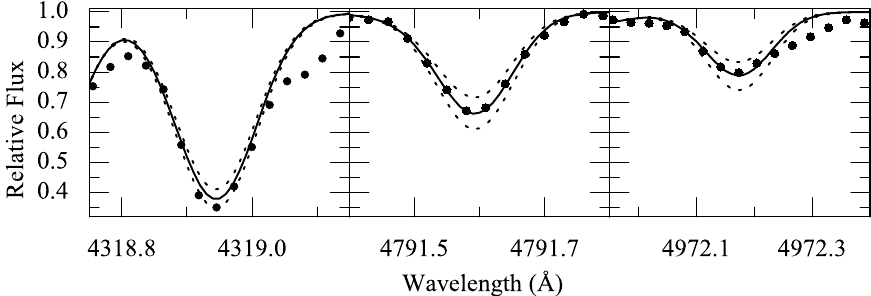
Fig. 21. Sm II lines in the spectrum of HD 209621. The synthetic spectra are given for the samarium abundance log ϵ (Sm) = 0 . 56 ± 0 . 15. of neodymium. The mean abundance was found to be log ϵ (Nd) = 1 . 11 ± 0 . 12 from equivalent widths. Synthesis of the three selected lines supports this value (Figure